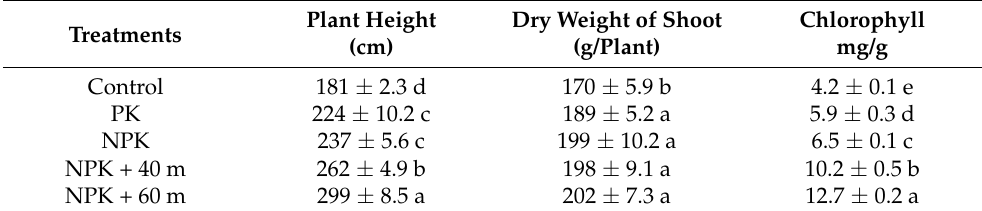
Table 7. Plant height, shoot dry weight, and chlorophyll content of the